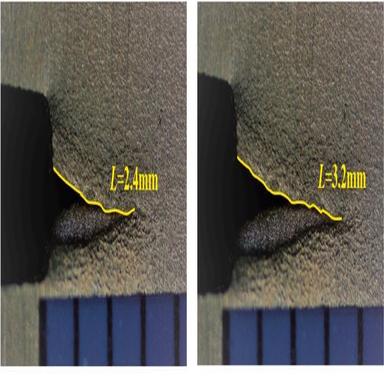
Captured photographs of the crack configuration at different locations along the path of mode I crack propagation.